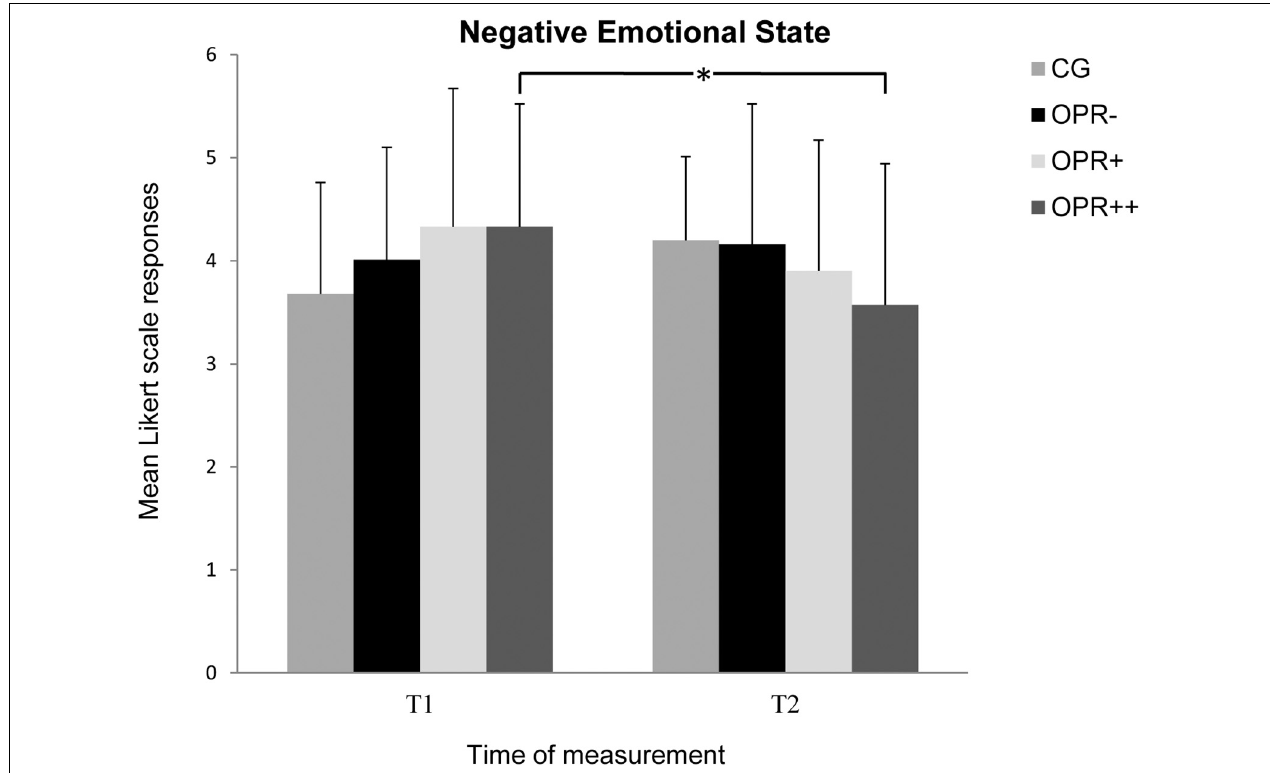
FIGURE 6 | The mean values of the Negative Emotional State of the groups as a function of the time of measurement (T1, T2). The symbols represent across-participant means, and error bars show standard deviations. The 7-point Likert scale ranged from “does not apply at all” (0) to “fully applies” (6). (CG: control group without any intervention; OPR - group: got a filled bottle of water every day without any label on it; OPR + group: got a filled bottle of water every day with the label “Imagine I Am Health”; OPR ++ group: got a filled bottle of water every day with the label “Imagine I Am Health” and an audio file with a health mediation) (*p <